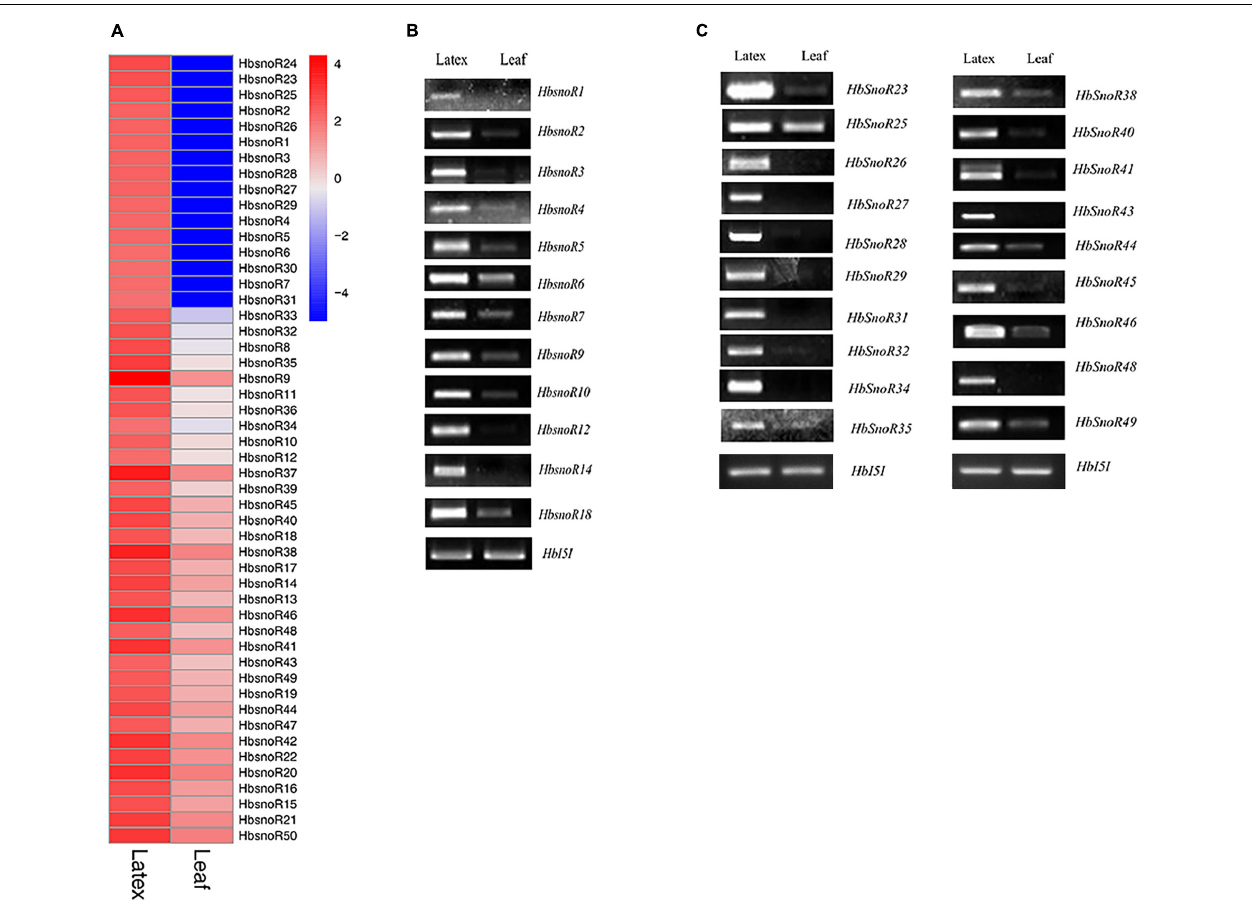
FIGURE 3 | Identification of latex-abundant small nucleolar RNA (snoRNAs). (A) Heatmap of differential expressed (DE) snoRNA expression between latex and leaf by comparative transcriptomic analysis. (B) Reverse transcription polymerase chain reaction (RT-PCR) validation of 12 latex-abundant C/D subfamily snoRNAs. (C) RT-PCR validation of 19 latex-abundant H/ACA subfamily